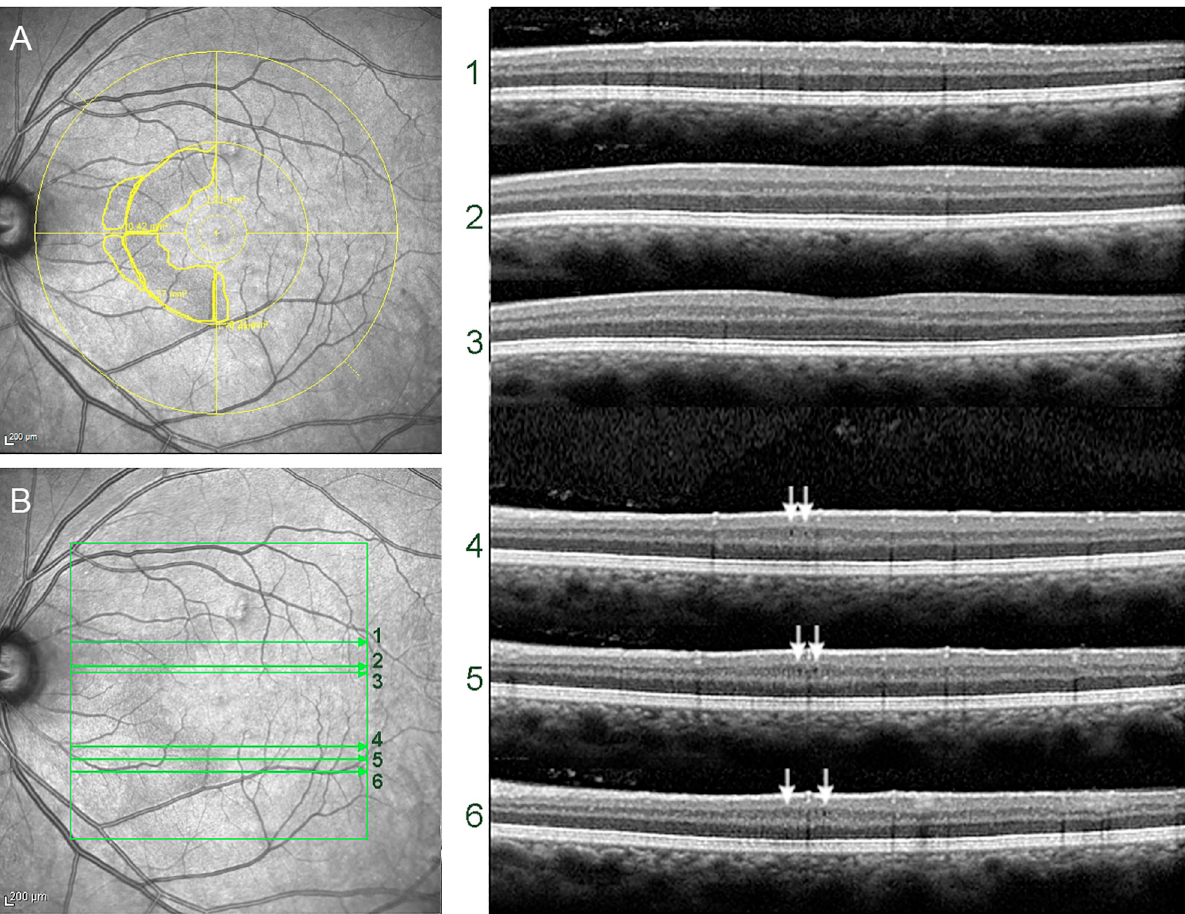
Fig 2. A: Example of NIR reflectance image showing hyporeflective abnormalities (HA) demarcated in a semilunar pattern in the nasal hemi-macula. B: The same picture as A, with B-scan lines (numbered 1 to 6) corresponding to those on the right. Note that OCT scan lines 1–3 display no microcysts despite coinciding with the HA area, while lines 4–6 are a positive match between HA and MMA (white arrows).